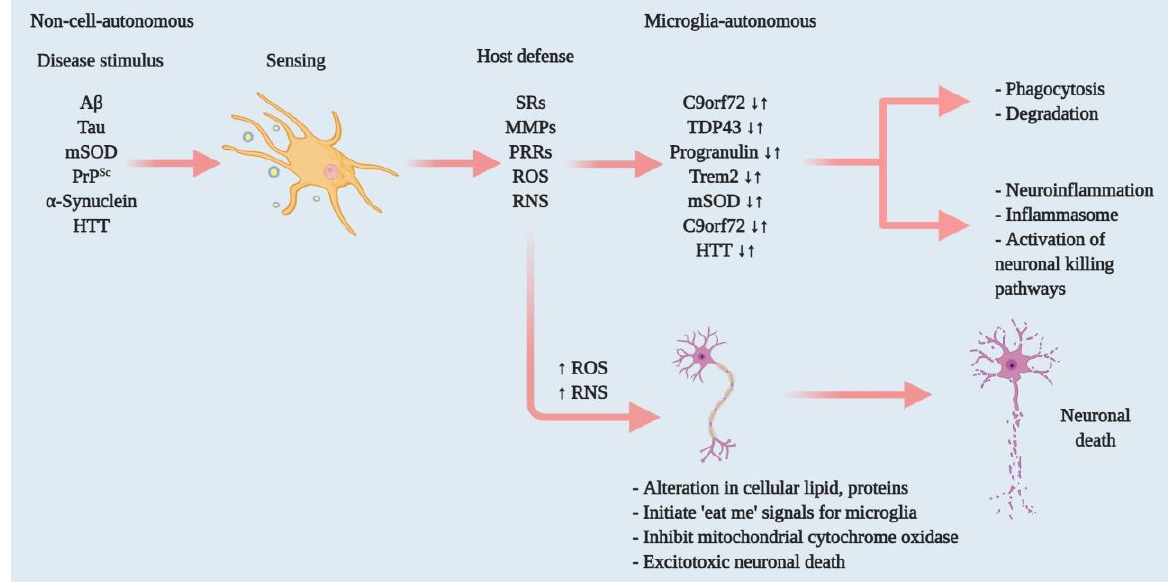
Figure 1. Effectors of microglia function associated with neurodegeneration and how microglia damage or kills neurons. Microglia have both host-defensive and detrimental actions, depending on the scenario. When they encounter aberrant or misfolded proteins—such as A β , aggregated α -synuclein, oxidised or mSOD1, or PrP Sc —they function as sentinels, protective hosts. In response to these toxic stimuli, microglia attempt to clear aggregated A β , α -synuclein or mSOD1 via SRs and other PRRs. However, the nature of the aberrant proteins or their continued production disrupts microglial housekeeping functions. Several pathways activate: NADPH oxidase produces superoxide and derivative oxidants; iNOS produces nitric oxide derivatives, glutamate, cathepsin B and other proteases, and that produces stressed neurons. These processes dysregulate the microglial host-defensive mechanism, leading to an exaggerated proinflammatory response, neurotoxicity and neurodegeneration. Microglia also include tumour necrosis factor (TNF) as an indirect pathway to damage or kill neurons via reducing brain-derived neurotrophic factor (BDNF) and insulin-like growth factor (IGF) production. Neurodegenerative diseases such as AD, ALS and HD, furthermore, cause mutations in specific genes that lead to self-autonomous dysregulation of host defence. This initiates or exaggerates proinflammatory responses, resulting in neurotoxicity and neurodegeneration. In this way, when mutations in TDP-43, progranulin and Trem2 increase ( ↑ ), they affect phagocytosis and associated degradation pathways. Similarly, mutations in mSOD and HTT ( ↑ ) also affect inflammasome activation and neuronal killing pathways. On the other hand, mutations in C9orf72 can affect both phagocytosis and inflammasome pathways. In normal physiology, a microglia-autonomous mechanism controls the scenario by clearing ( ↓ ) mutant or aberrant proteins (adapted from ref.